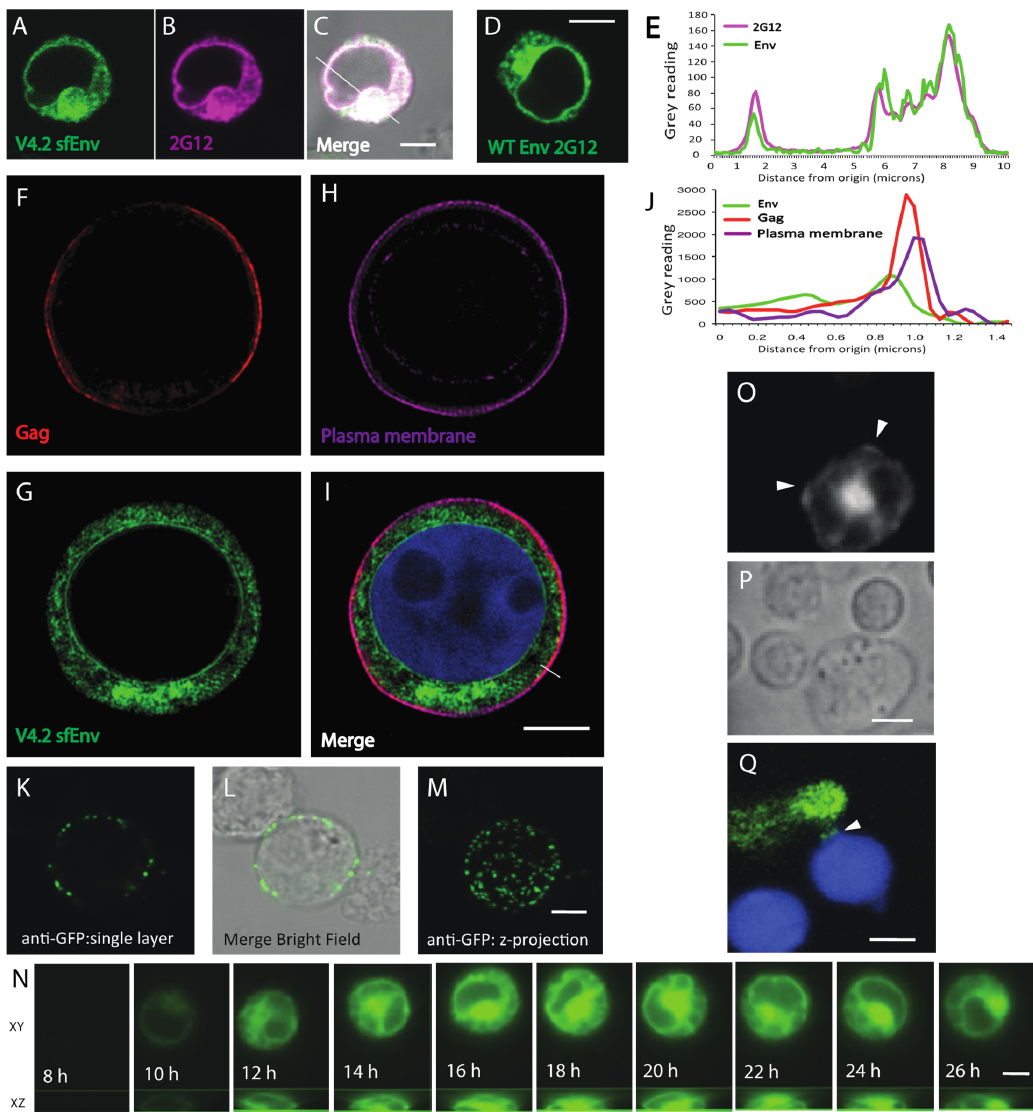
Figure 2. Fluorescence microscopy showing cellular distribution of sfGFP-tagged Env in Jurkat cells. ( A – D ) Confocal fluorescence microscopy of Jurkat cells transfected with HIV Env V4.2-Gag-iCherry were fixed and stained with anti-Env mAb 2G12 (Magenta). ( A ) V4.2 sfGFP Env localization, ( B ) 2G12 Env immunostaining, ( C ) Merged image with bright field overlay. ( D ) Confocal microscopy image of WT NL4-3 Env stained with anti-Env mAb 2G12 (Green). ( E ) Graph shows the fluorescence intensity of Env and 2G12 staining traced along the line indicated in ( C ). ( F – I ) Super resolution structured illumination imaging of Jurkat cell nucleofected with HIV V4.2-Gag-iCherry were stained with cell mask deep red. ( F ) Cherry-Gag; ( G ), sfGFP-Env, ( H ) Cell Mask; ( I ), Merged image plus nuclear DAPI stain (blue). ( J ) Graph shows the fluorescence intensity of Gag, Env and plasma membrane along the line as indicated in ( I ). ( K – M ) Cell surface Env was stained with anti-GFP followed by secondary antibody while cells were alive at 4 ◦ C. The cells were then imaged for surface anti-GFP Env